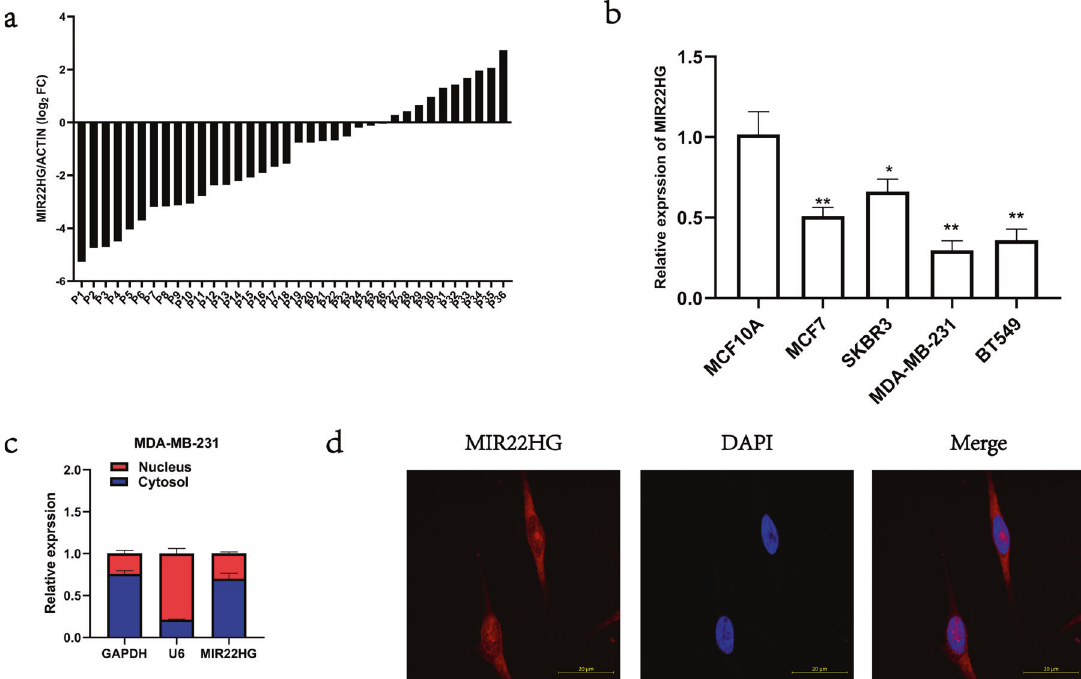
Fig. 1 Expression and subcellular distribution of MIR22HG . a MIR22HG expression in 36 pairs of cancerous and adjacent normal breast tissues detected by real-time PCR, with β -actin as internal control. b MIR22HG expression in normal breast epithelial cell line MCF10A and breast cancer cell lines MCF7, MDA-MB-231, BT549, and SKBR3 detected by real-time PCR, with β -actin as internal control. c MIR22HG expression in subcellular fractions of MDA-MB-231 cells detected by real-time PCR, with U6 and GAPDH as nuclear and cytoplasmic markers, respectively. d Fluorescence in situ hybridization analysis revealed that MIR22HG (red) was mainly located in the cytoplasm. DAPI-stained nuclei are in blue (in 63*oil lens). * P < 0.05, ** P < 0.01. All experiments were repeated